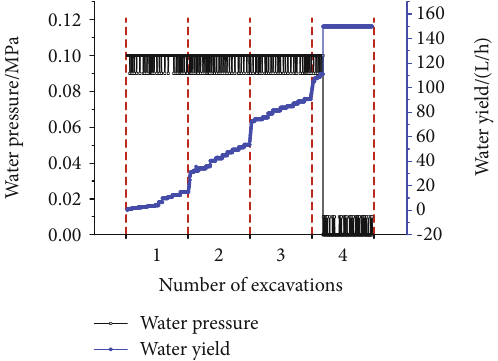
Figure 14: Changes of water pressure and water